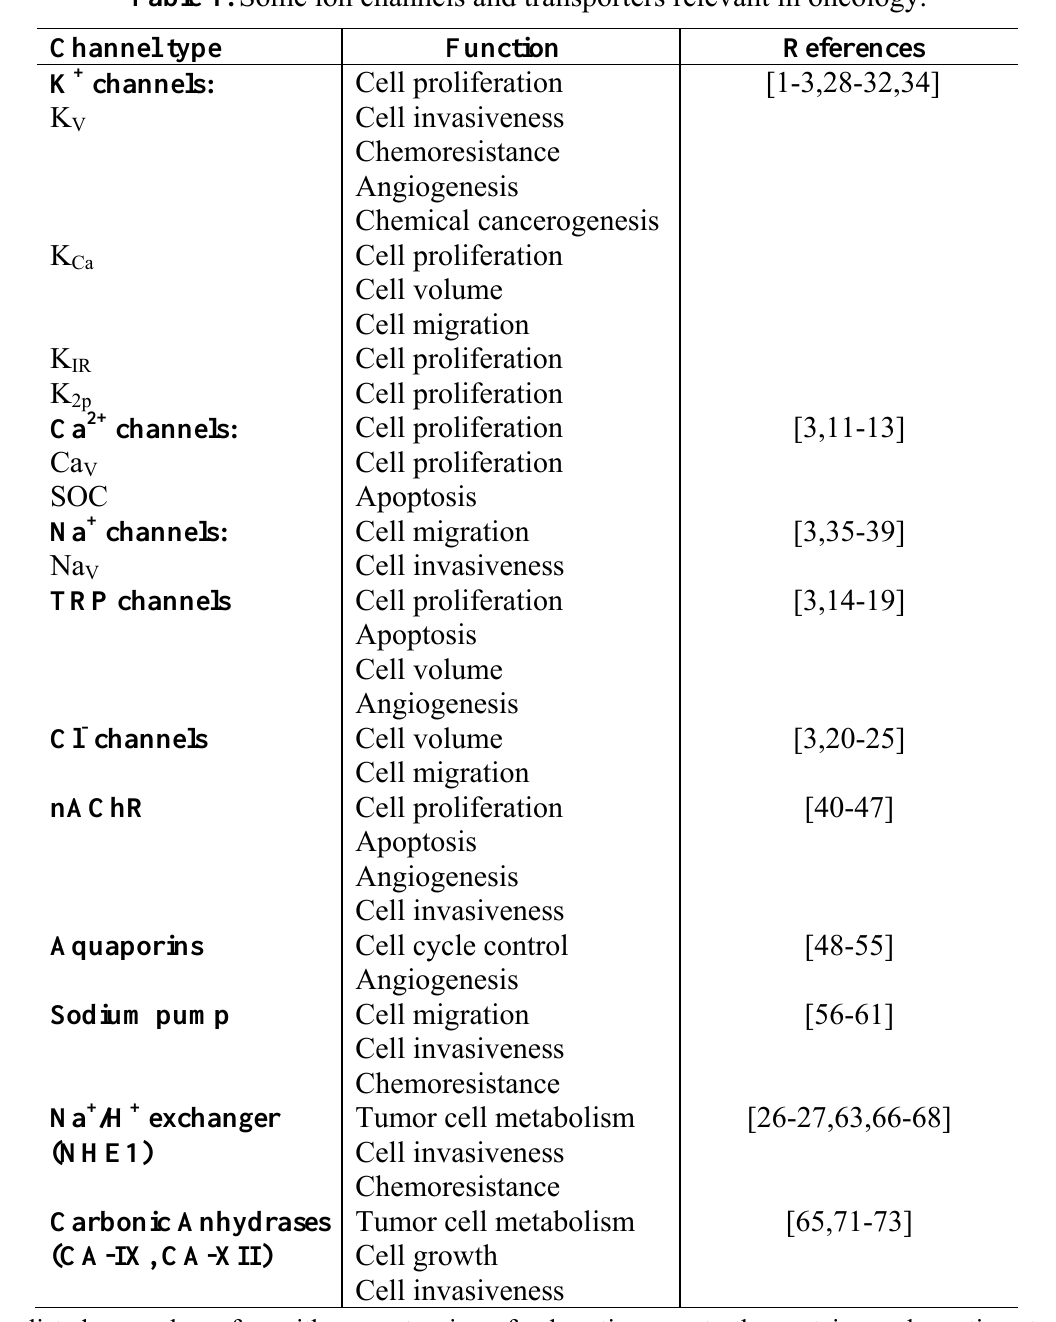
Table 1. Some ion channels and transporters relevant in